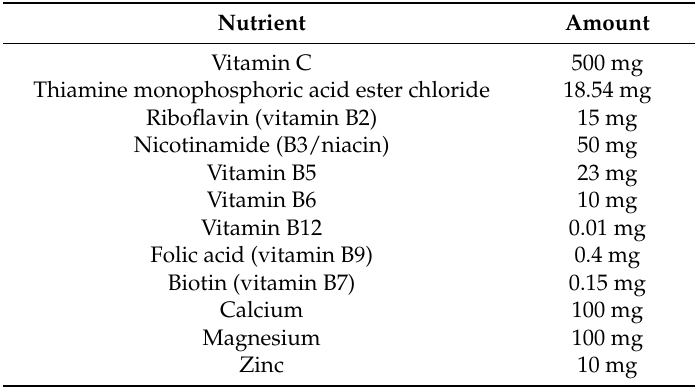
Table 1. Doses of vitamins and minerals in active multi-vitamin/mineral (MVM)